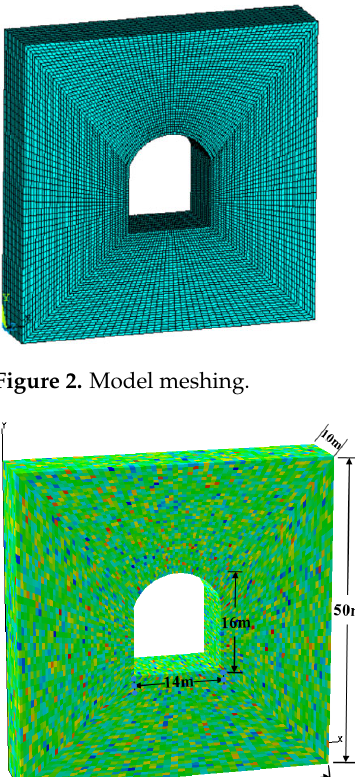
Figure 3. A 3D calculation model.